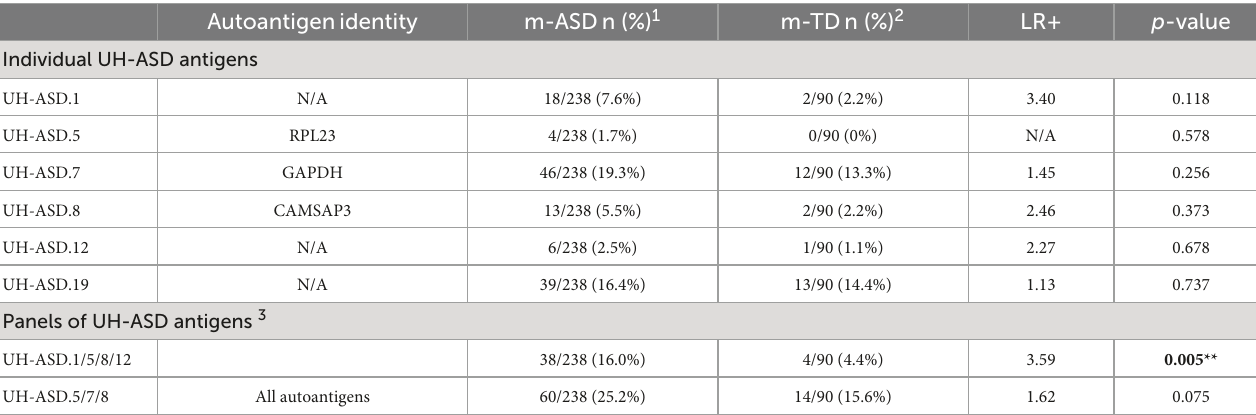
TABLE 3 Antibody reactivity to individual and combinations of UH-ASD antigens in m-ASD and m-TD samples. Autoantigen